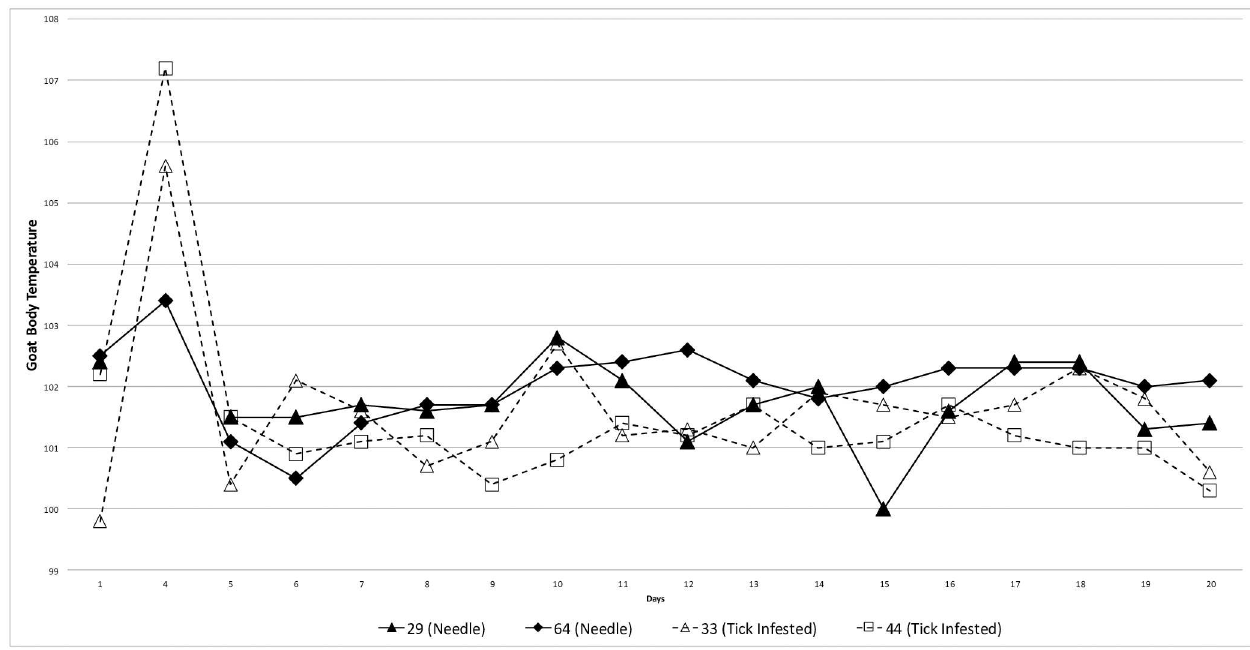
Fig 1. Core body temperature in goats infected with the North American Isolate of Rickettsiaslovaca